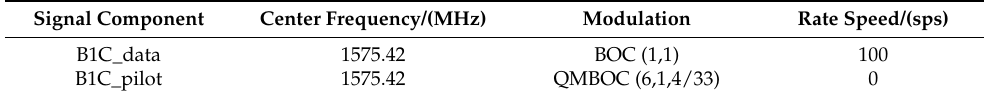
Table 1. The characteristics of the B1C signal